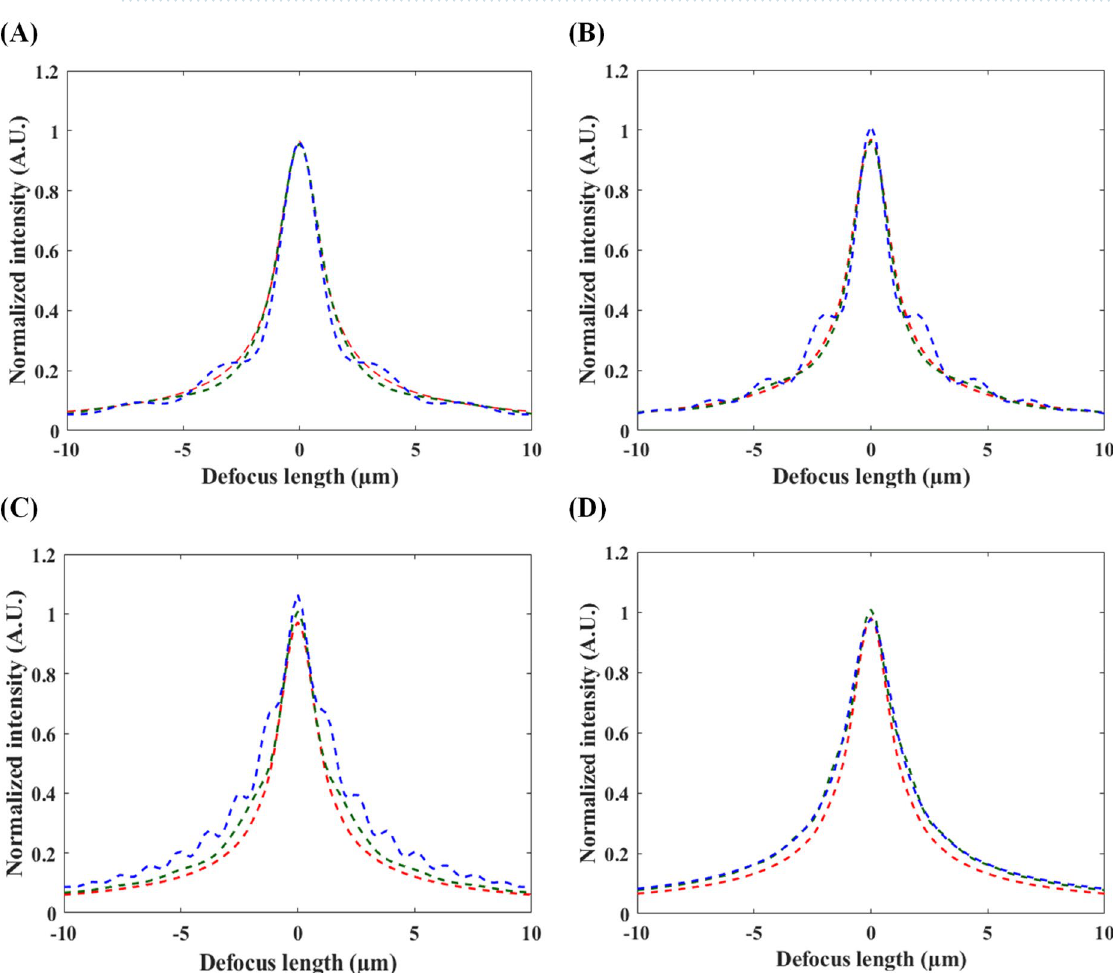
Figure 2. AEC profiles for four sinusoidal structured light patterns with spatial frequencies of: ( A ) 0.65 μm −1 , ( B ) 0.81 μm −1 , ( C ) 1.09 μm −1 , and ( D ) 1.3 μm −1 . Note that each figure shows three orientations of the modulated light pattern, i.e., 0° (red), 45° (green), and 90°